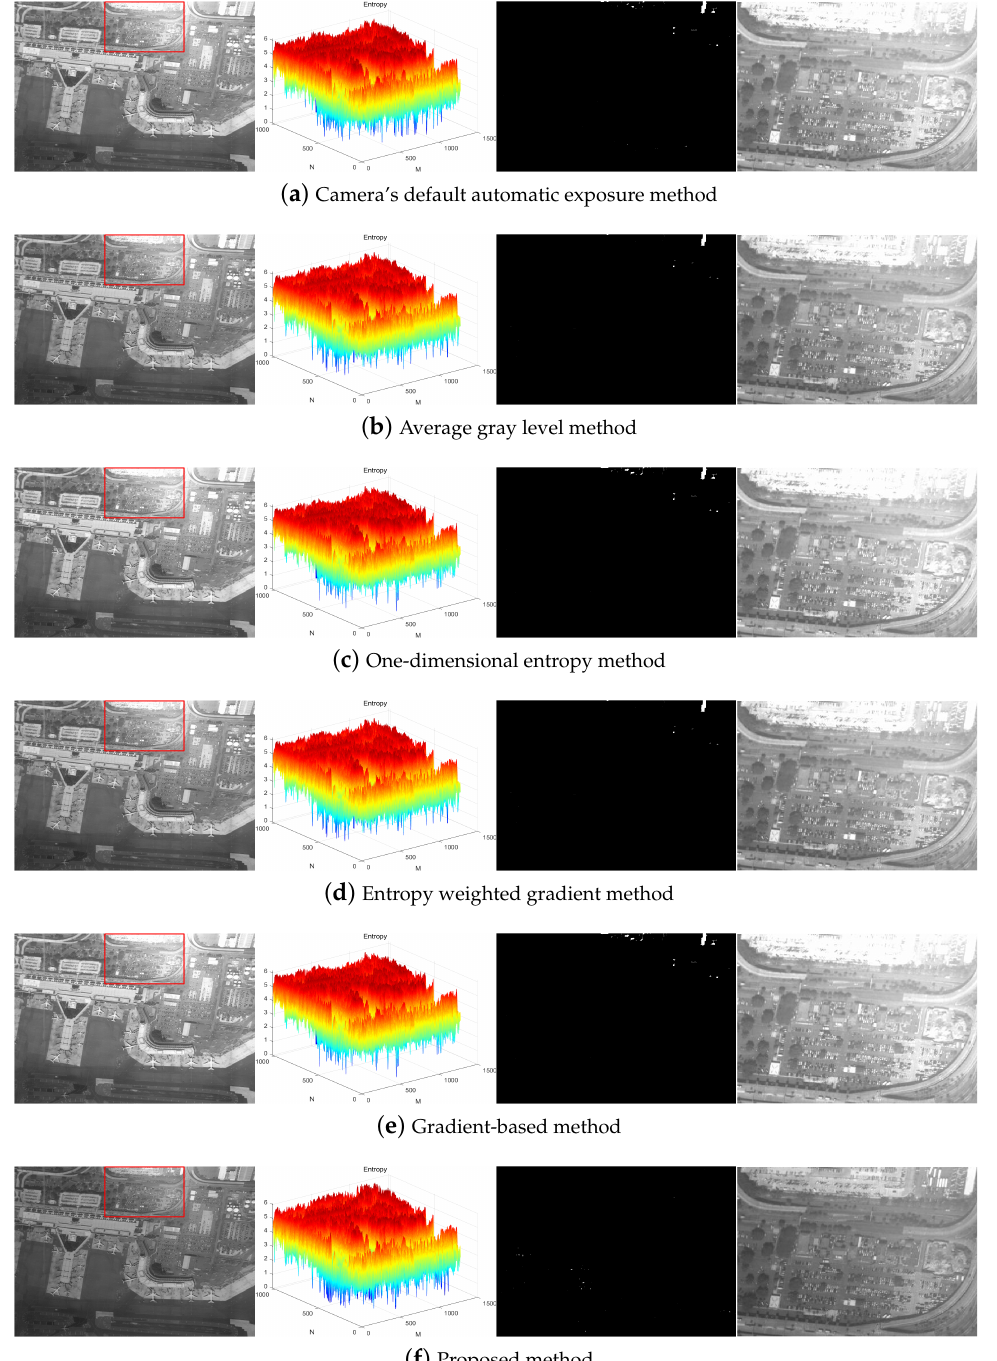
Figure 3. The optimal exposure image, the three-dimensional image entropy matrix, segmentation of ROS, and the enlarged view of the labeled region of each method under bright conditions from left to